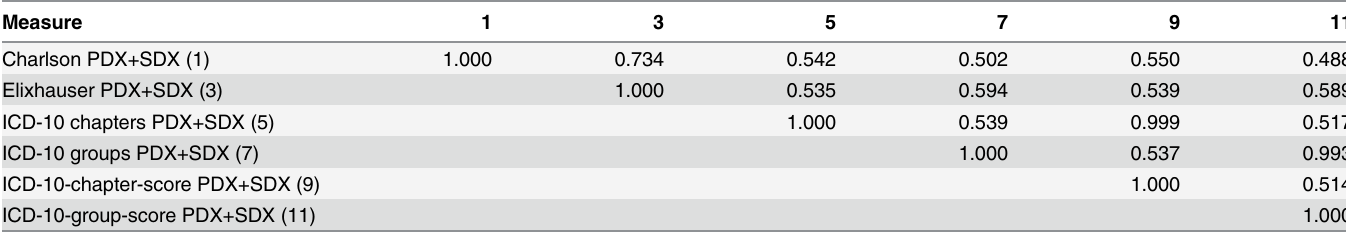
Table 2. Non-parametric correlation coefficient from the correlation analysis of the comorbidity measures including the PDX. Measure